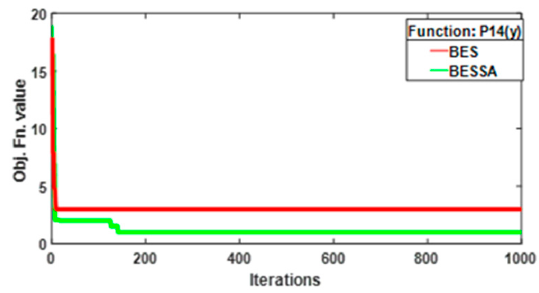
Figure 7. Convergence profile for function p 14 .